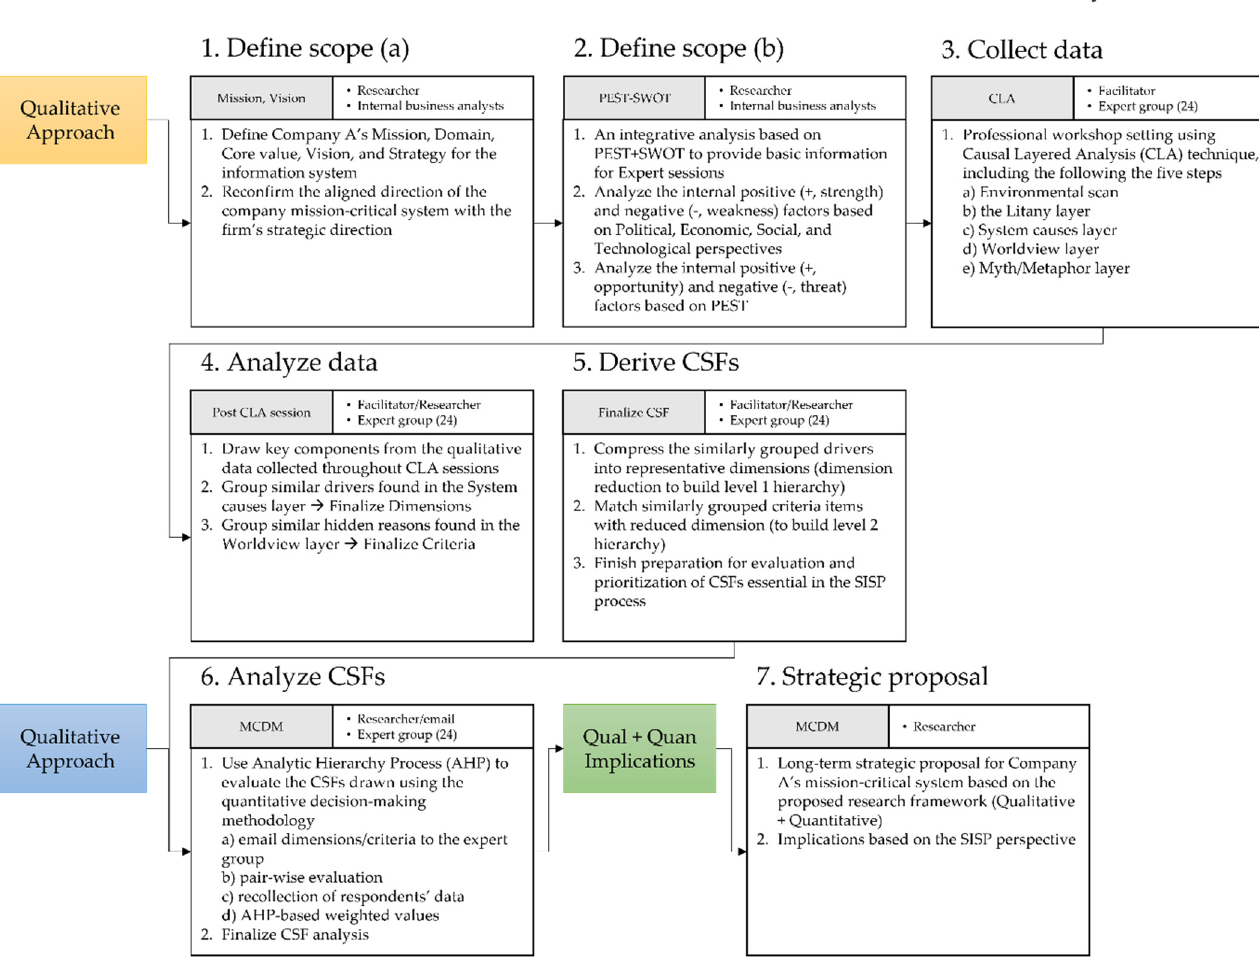
Figure 1. Research design.